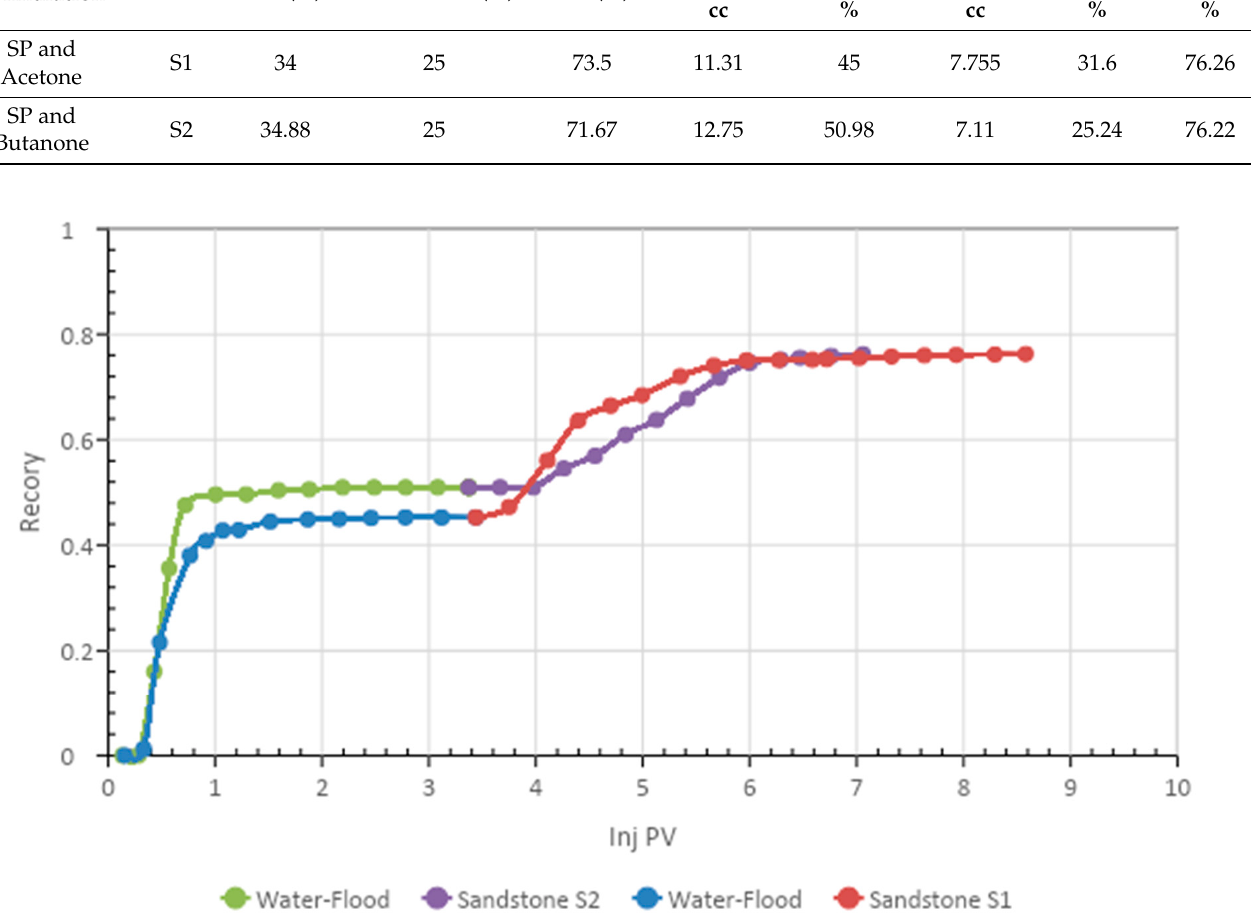
Figure 13. Total oil recovery observed from the two formulations.